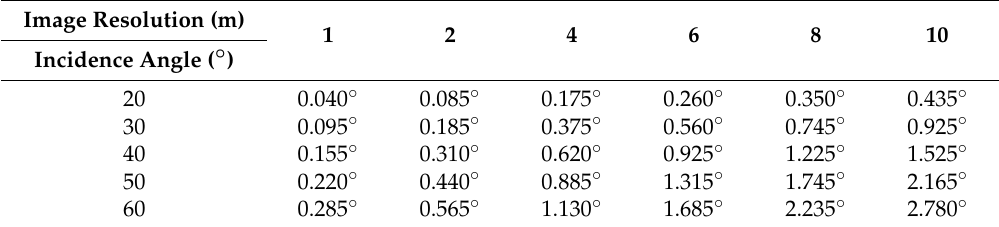
Table 2. Maximum incidence angle differences under different image resolutions and different incidence angles.